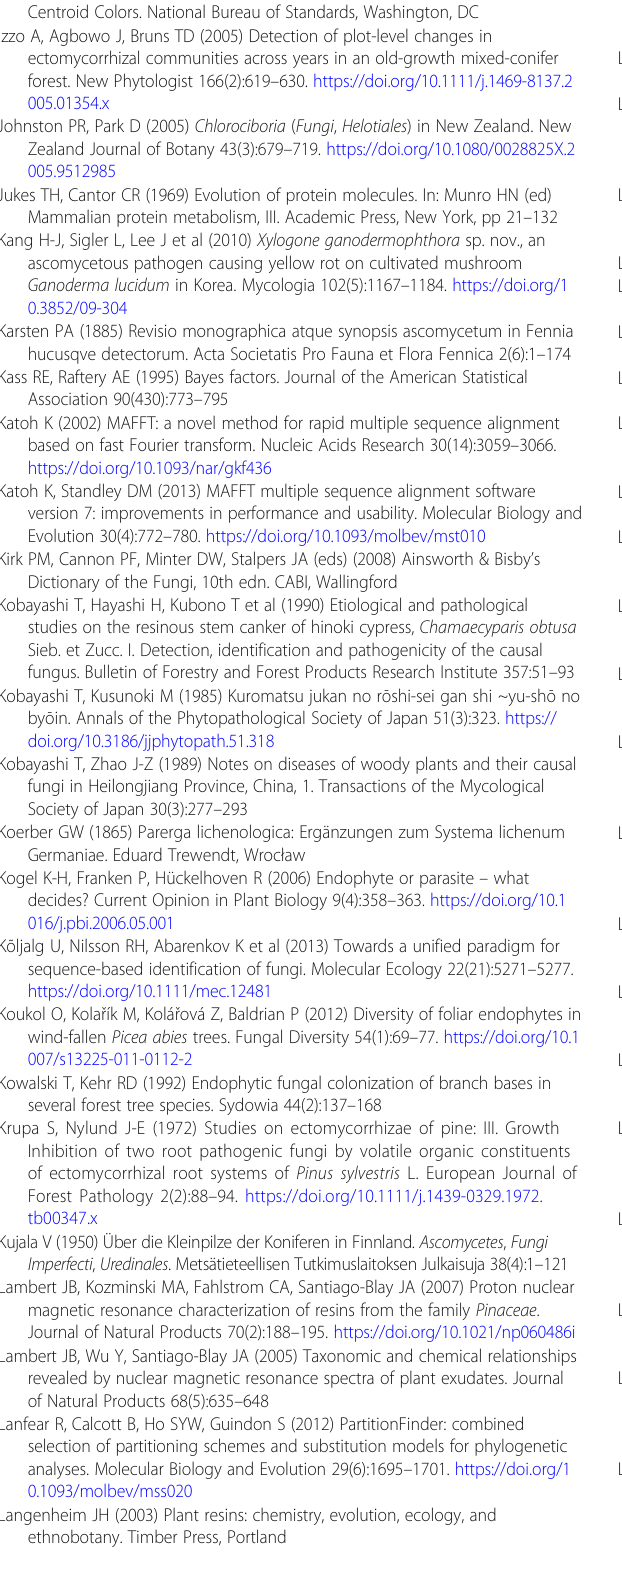
Inter-Society Color Council (1976) ISCC-NBS Color-name Charts Illustrated with Centroid Colors. National Bureau of Standards, Washington,